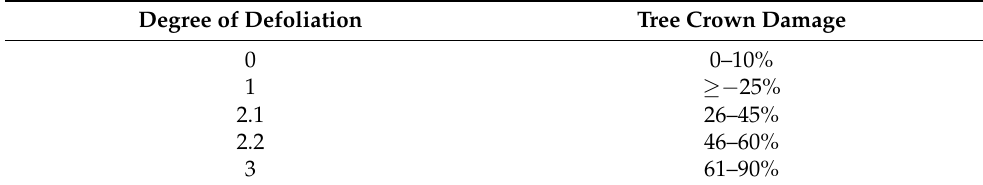
Table 3. Degrees of defoliation according to the GOSSGE protocol.